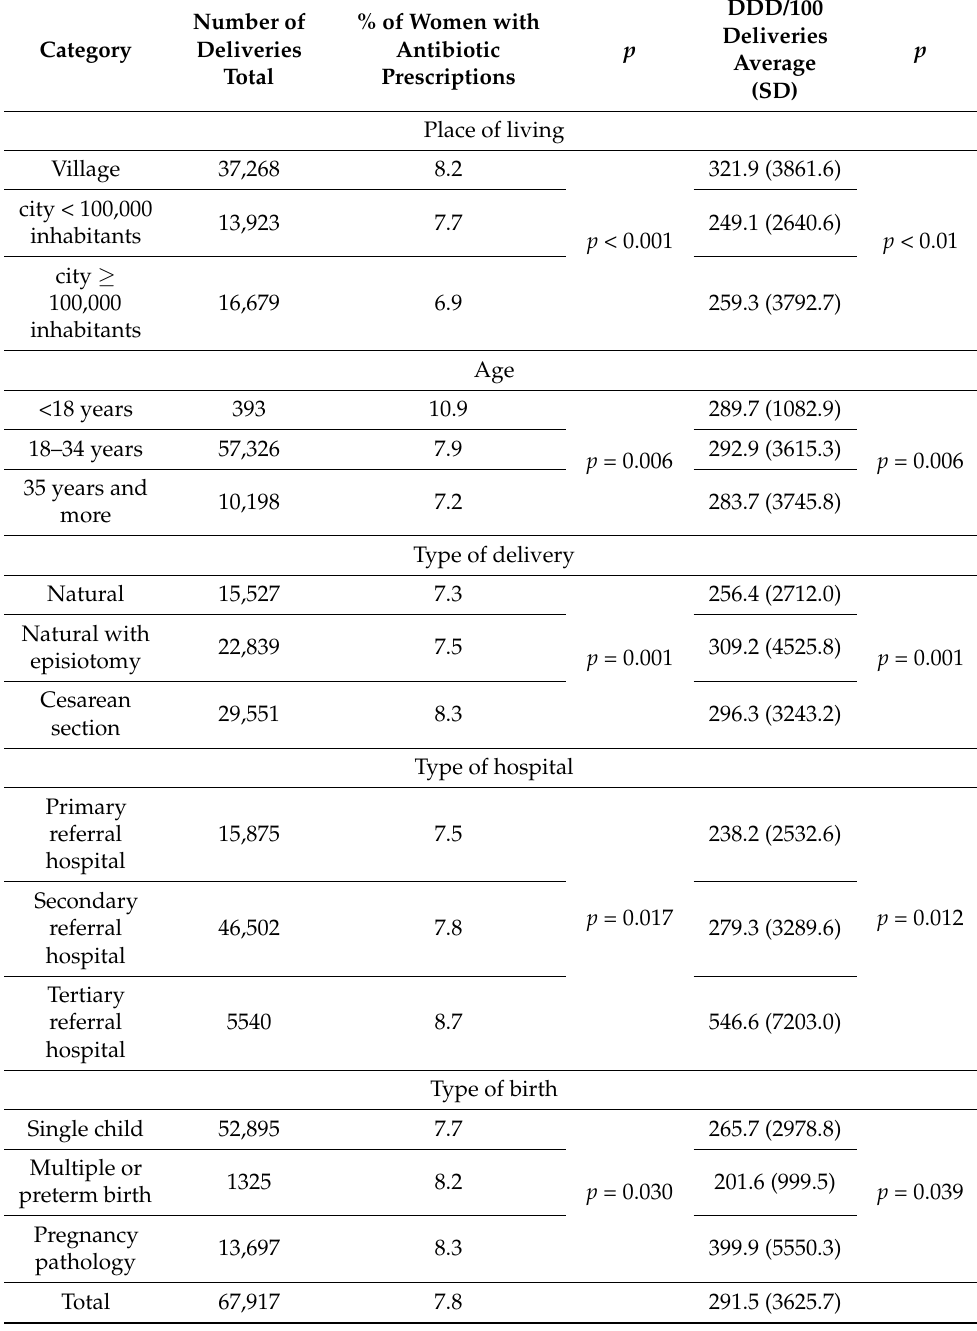
Table 3. Number of prescriptions and DDD for first trimester of pregnancy according to place of living, hospital type, women’s age, and type of